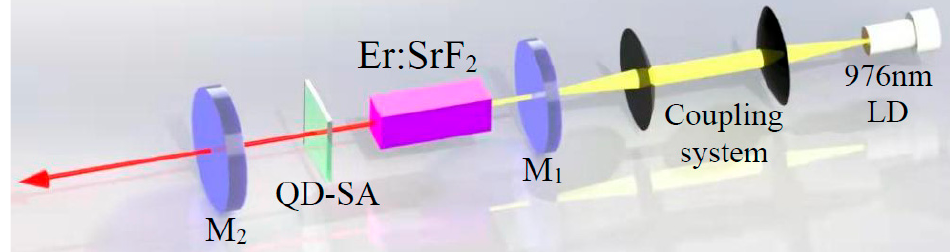
Figure 2. Passively Q-switched experimental setup with the CsPbCl 3